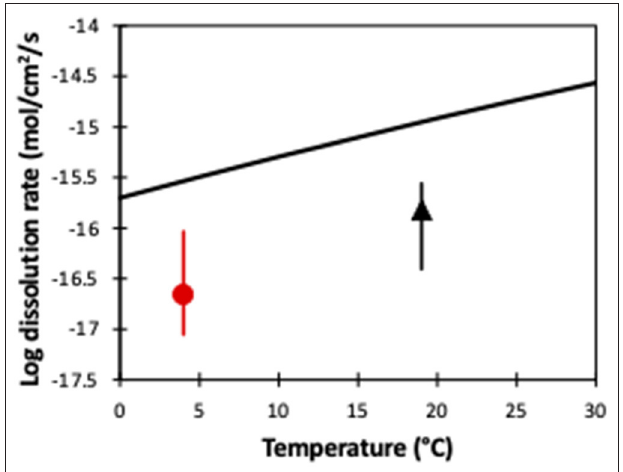
FIGURE 6 | A comparison of olivine dissolution rates from pure laboratory experiments (black line) and our soil column experiments (this study and Renforth et al., 2015), as a function of temperature. The symbols represent the average value, while the error bars represent the entire observed range of dissolution rates ( Figure 5